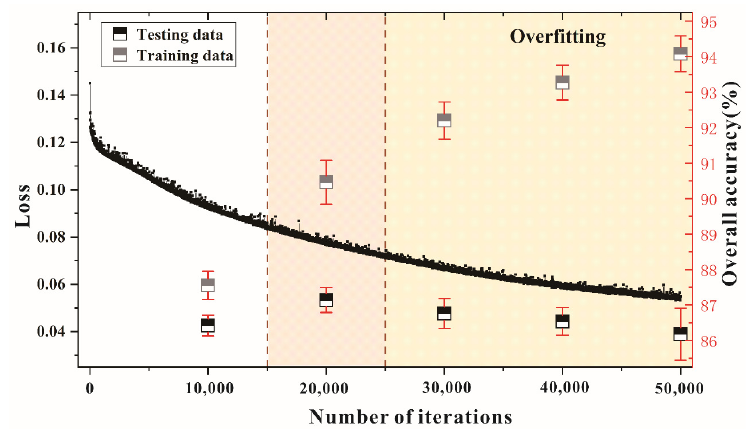
Figure 7. Overfitting when the number iteration is over 20,000.